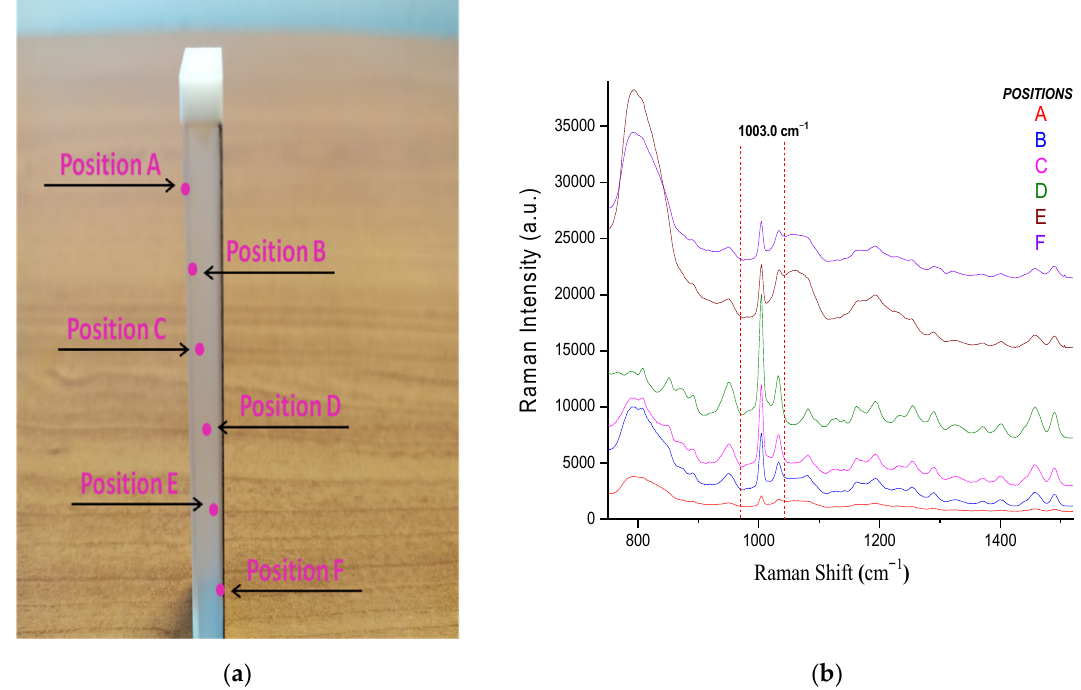
Figure 7. ( a ) Schematic illustration of the cross-section of the Raman cell depicting the depth of the six different focus positions of the laser beam, starting from the external quartz surface to the mirror surface for the spectra acquisition (for better clarity, each position of the focused beam is depicted along the diagonal of the cell), ( b ) Raman spectra of the liquid formulation (40.00 mg PIP/mL and 5.00 mg TAZ/mL) placed in the cell, each one corresponding to the radiation focus positions illustrated in part ( a ) of the figure.